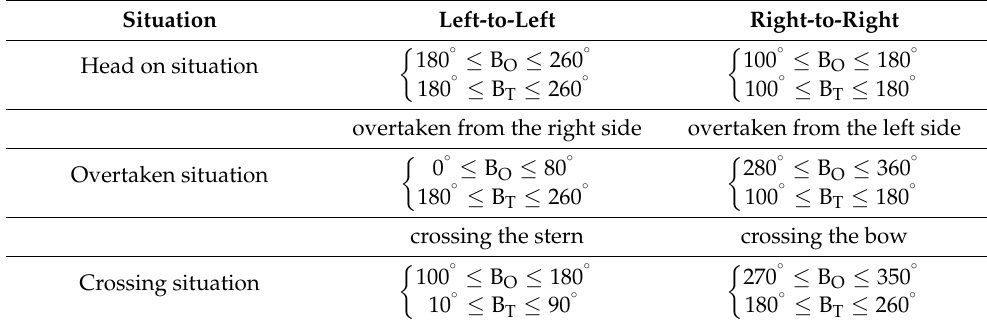
Table 4. Relative bearing